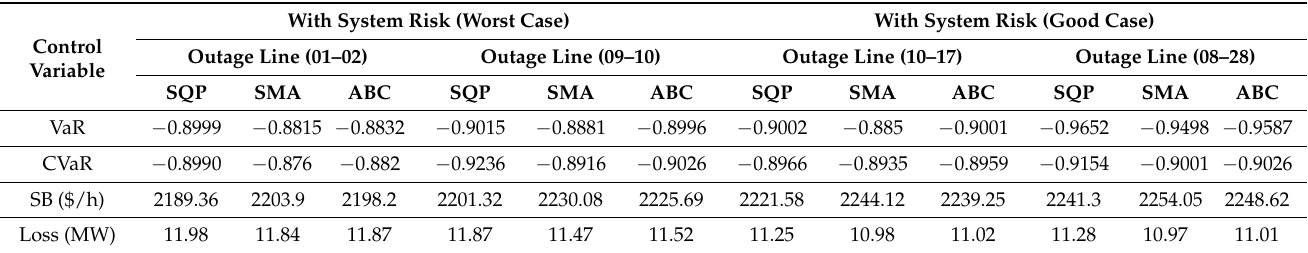
Table 6. Social benefit and loss values considering system risk under deregulated environment for IEEE 30-bus systems.